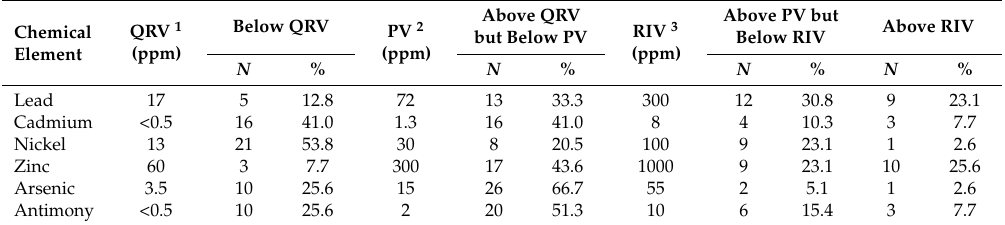
Table 7. The quality of soil indicators according to the Brazilian guidelines for soils in the 39 households from Santo Amaro City,